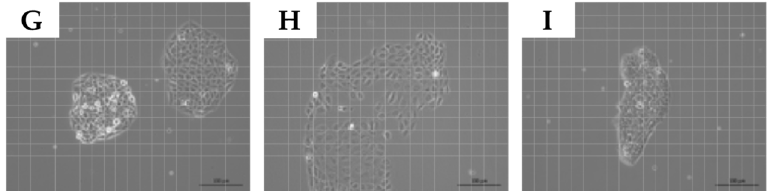
Figure 1. Growth patterns of urothelial cells. Normal urothelial cells (NUCs; ( A )) and urothelial carcinoma cells (UM-UCs; ( B – I )) were seeded in cell culture flasks and growth patterns were recorded by microscopy. NUCs and UM-UC-13 proliferated as individual cells and generated confluent layers in time. The other UM-UC lines grew in clusters. Size bars indicate 100 µ M.